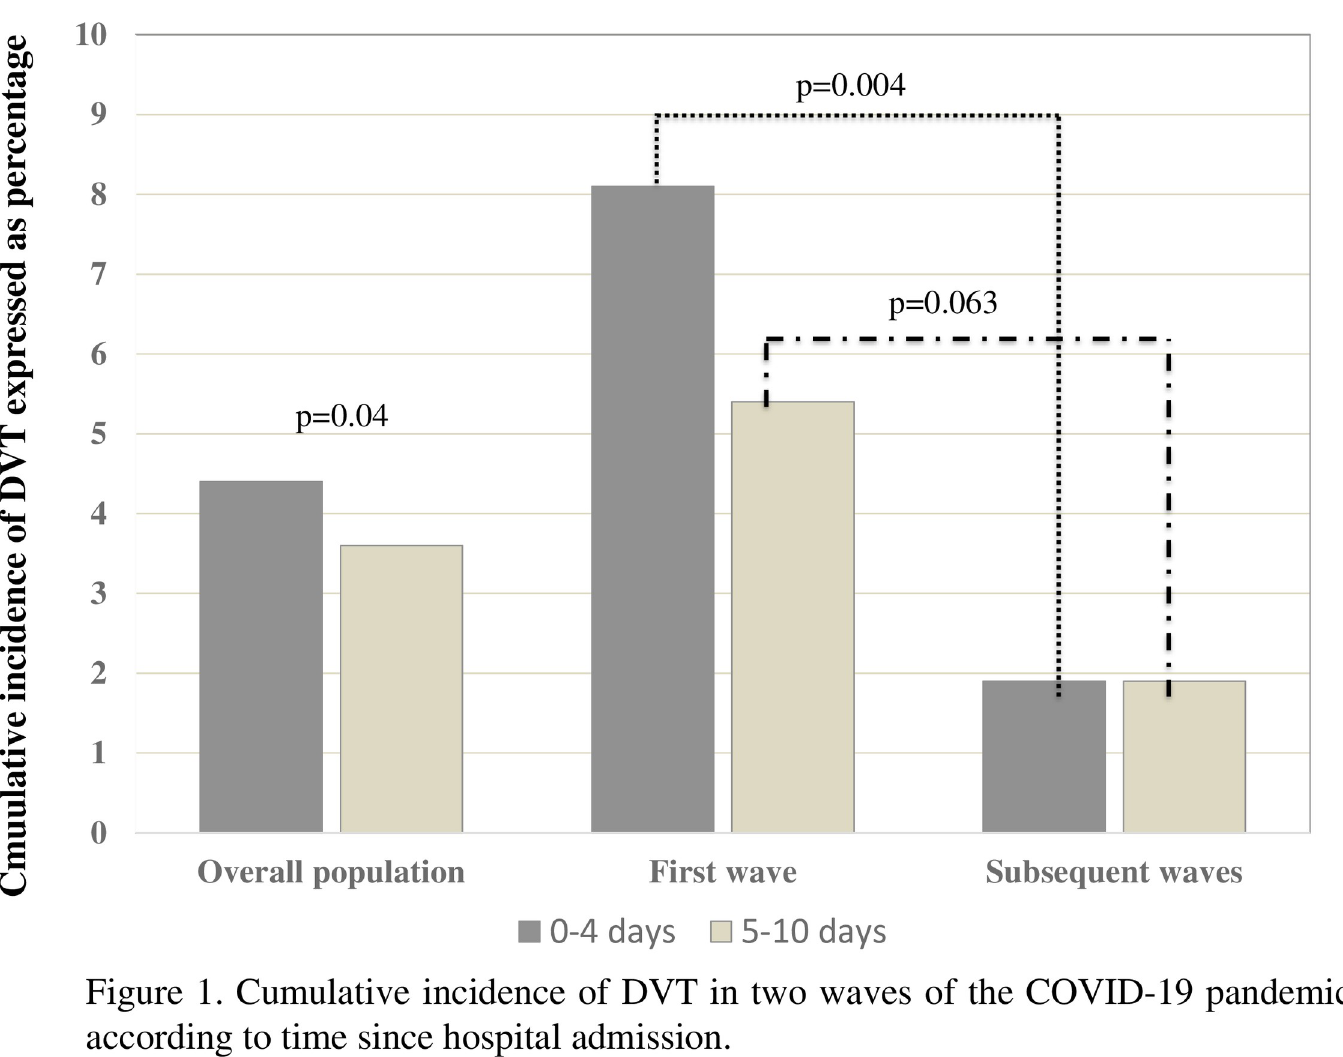
Fig 1. Cumulative incidence of DVT in two waves of the COVID-19 pandemic according to time since hospital